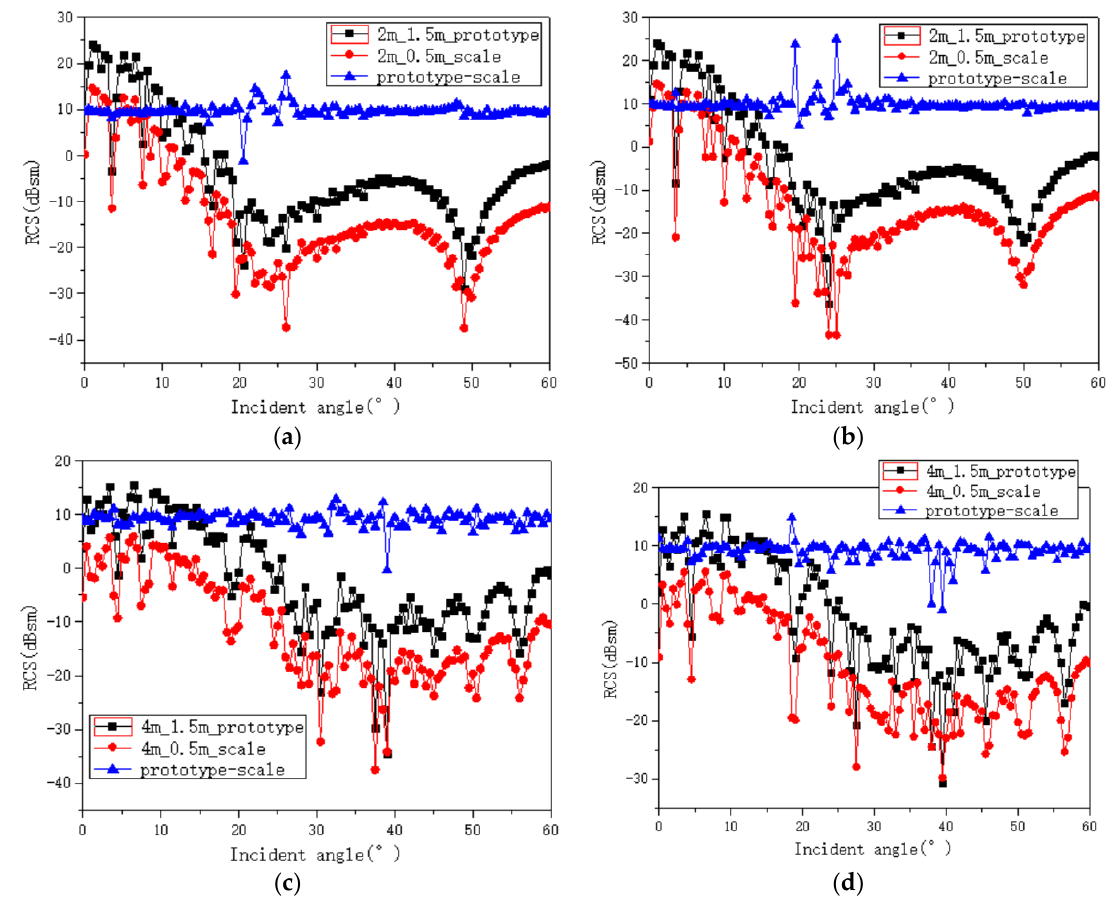
Figure 12. The RCS (dBsm) variation of the prototype and scaled rough sea surfaces with the incident angle. The black line represents 1.5 m × 1.5 m of the prototype sea surface. The red line represents 0.5 m × 0.5 m of the sea surface. The blue line shows the difference ( T = 9.6 ◦ C, S = 4 psu). ( a ) f = 7.75 GHz, U 12.5 = 2 m/s; ( b ) 7.85 GHz, U 12.5 = 2 m/s; ( c ) f = 7.75 GHz, U 12.5 = 4 m/s; ( d ) f = 7.85 GHz, U 12.5 = 4